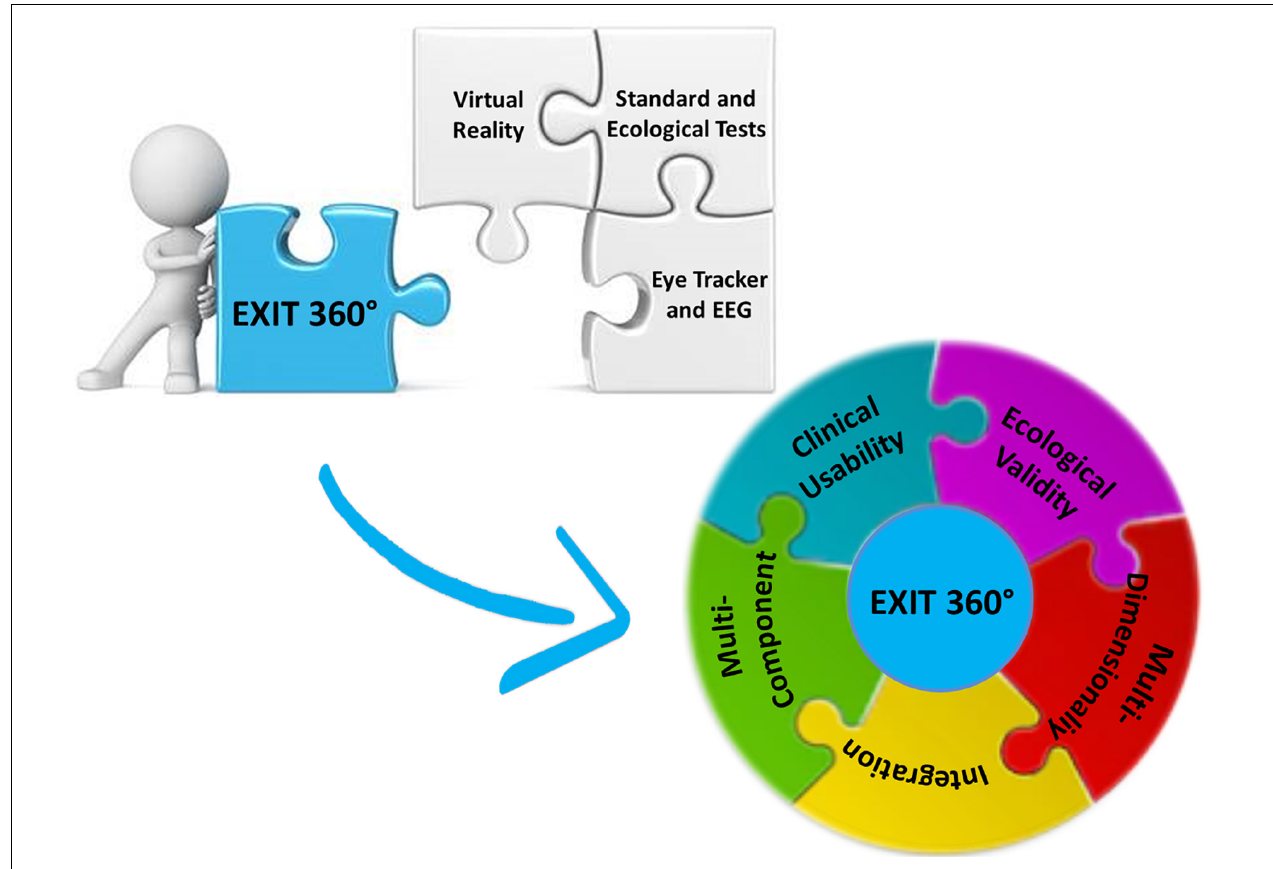
FIGURE 1 | The five pillars behind our innovative 360 ◦ assessment tool for EF.